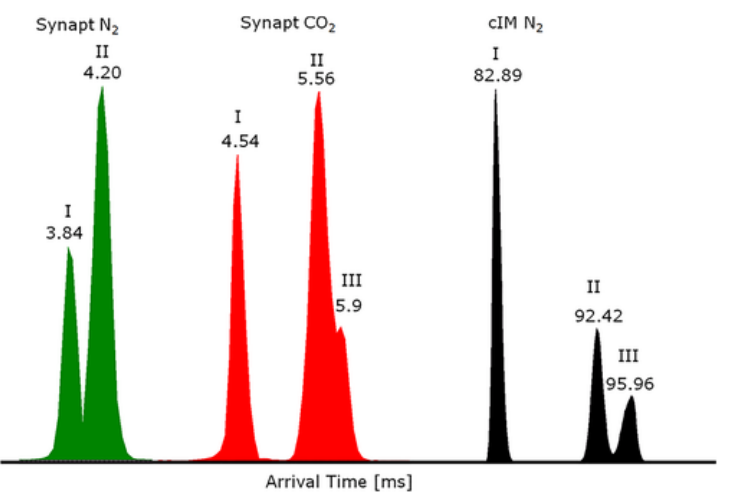
Figure 6. Danofloxacin IMS protomer separation using the Synapt (N 2 and CO 2 IMS gas) and cyclic-IMS (N 2 IMS gas, 5 passes) systems. Figure reprinted with permission from [126]. Copyright (2019) Wiley.